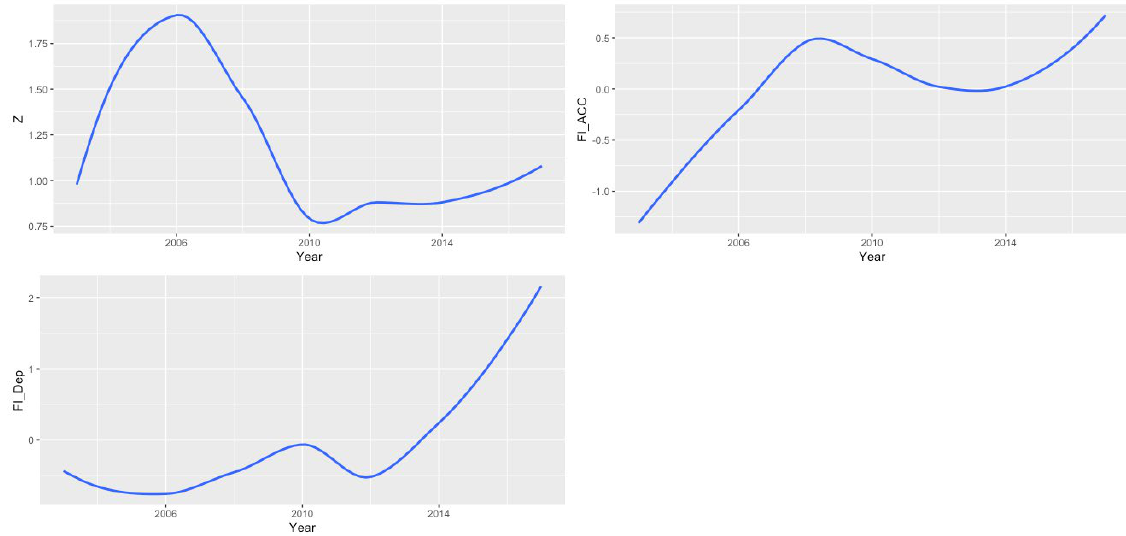
Figure 1. Trends of bank stability, FI_A, and FI_D, over the period between 2003 and 2017. Pearson pairwise correlation coefficients between the variables are given in Table 4.